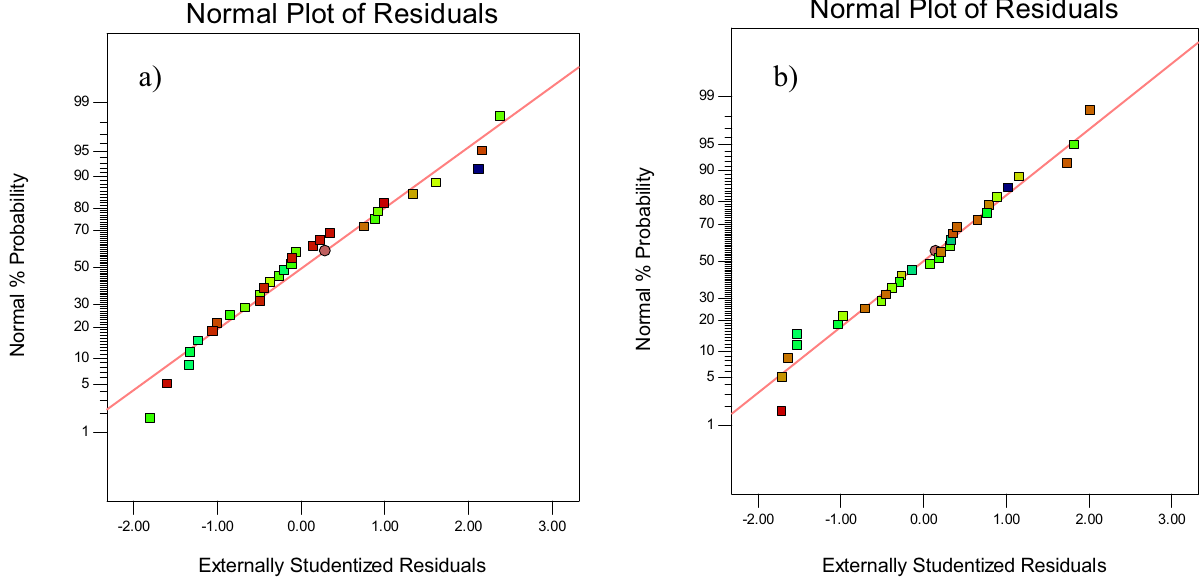
Figure 4. The plots of normal probability of the residuals for extraction of ( a ) AO and ( b ) MB (Image is created by using Design-Expert software version